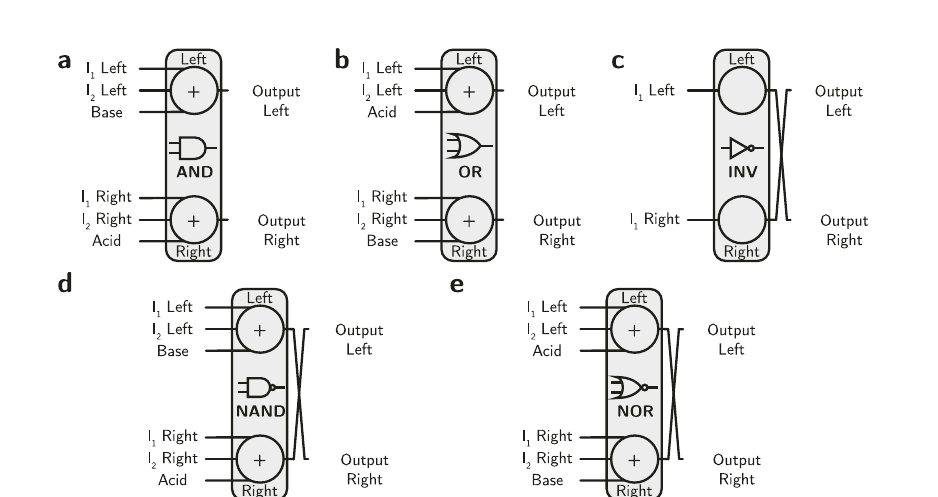
Fig. 2 | Primitive logic gates represented by acid-base blocks. a AND gate, b OR gate, c INVgate, d NANDgate, e NORgate.Eachgatewithanevennumberofinputs requires a third biasing value to implement its function and eliminate neutrality.